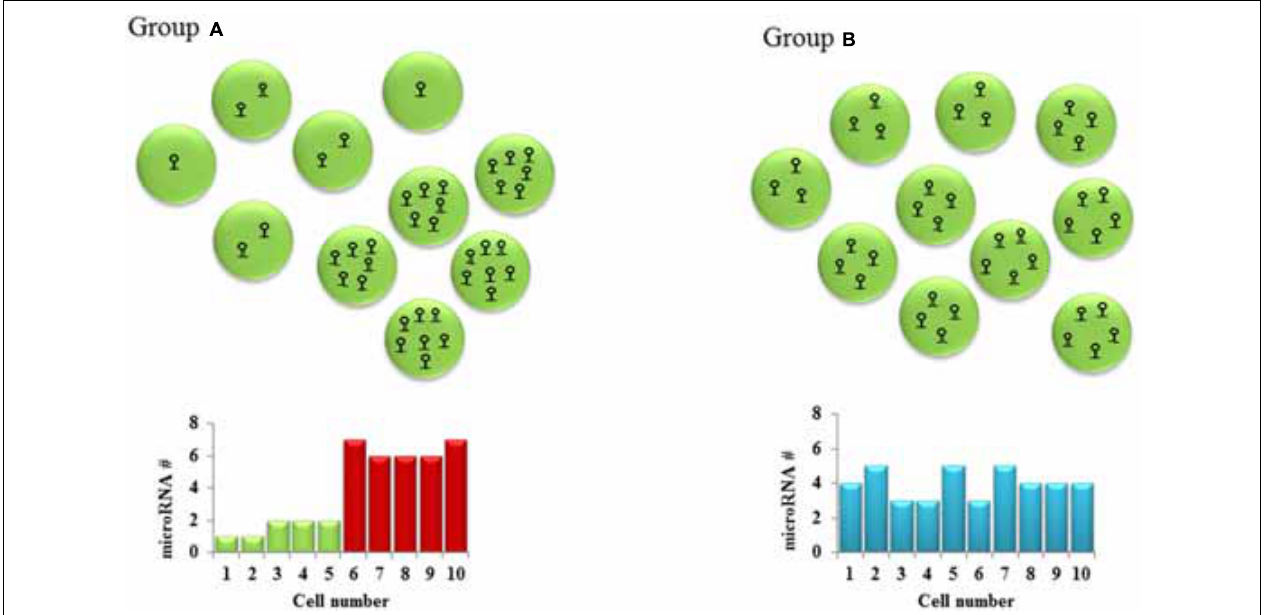
FIGURE1|CellularheterogeneityinmicroRNAlevels:Hypotheticalcell groups(A,B)havethesameaveragenumberofaparticularmicroRNAper cell(average = 4). SNAextractionandqPCRofboththesegroupsofcells wouldgivethesamemicroRNAexpressioninbothgroups.However,acloser